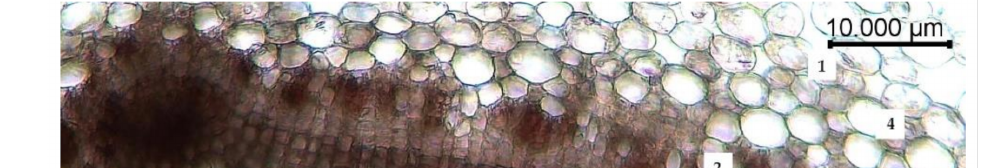
Figure 4. Changes in the anatomical structure of the stem of R. semenowii under stress conditions: ( a ) control, ( b ) water deficit (cessation of watering, 72 h), ( c ) cold stress (cold treatment +3 ◦ C, 72 h). 1—assimilation parenchyma; 2—conductive beam; 3—parenchymal cells of the core; scale bar = 10 µ